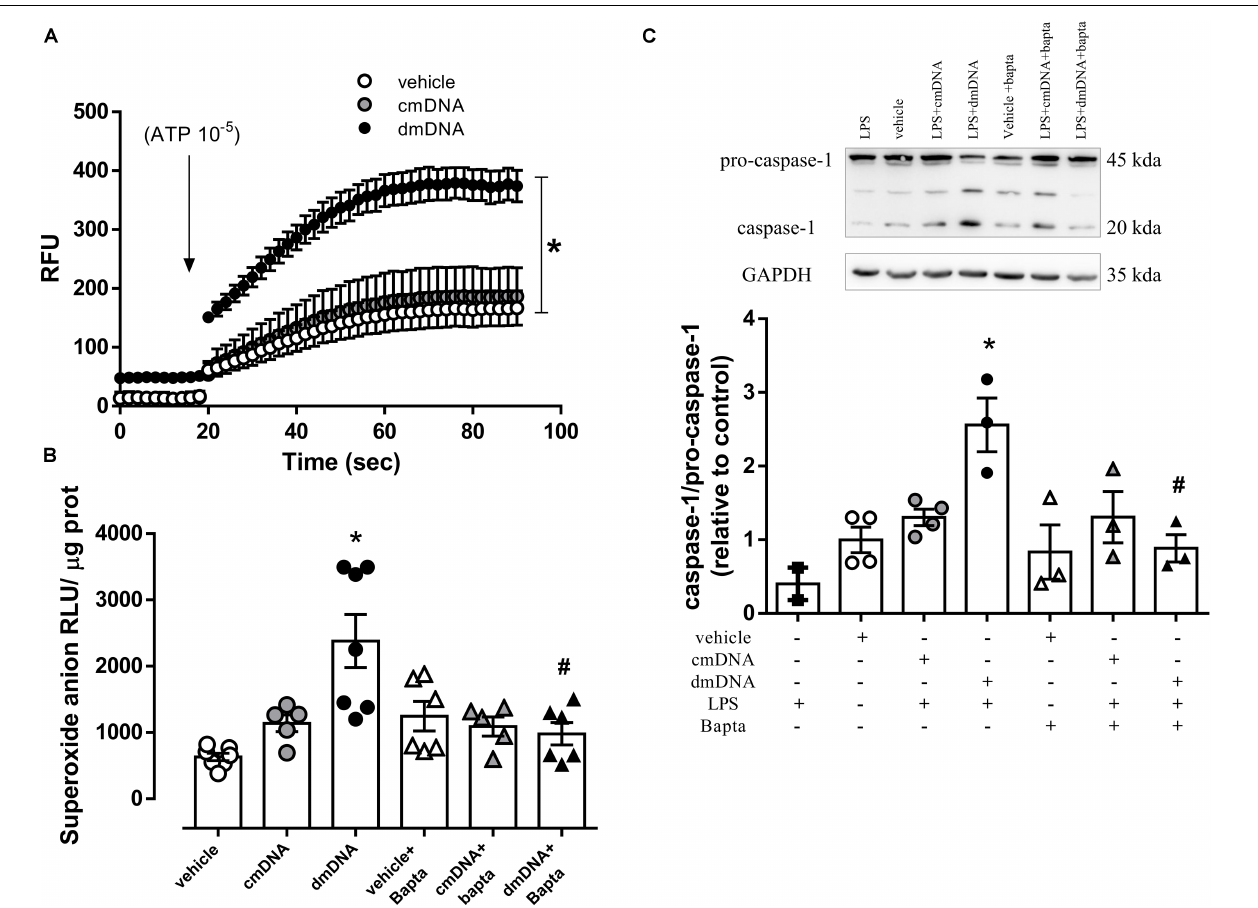
FIGURE 6 | (A) Ca 2 + influx and (B) superoxide anion generation in endothelial cells incubated with vehicle (white circles), mitochondrial DNA from control (cmDNA, gray circles) or diabetic (dmDNA, black circles) mice in the presence of vehicle (white triangles) or a Ca 2 + chelator (Bapta, gray and black triangles). On top, representative images of western blot and, at the bottom, densitometric analysis of the expression of (C) caspase-1 and pro-caspase-1 in endothelial cells primed with lipopolysaccharide (LPS) and incubated with vehicle (white squares), mitochondrial DNA from control (cmDNA, gray circles) or diabetic (dmDNA, black circles) mice in the presence of vehicle (white triangles) or a Ca 2 + chelator (Bapta, gray and black triangles). Each point/column represents the mean ± SEM. ∗ P < 0.05 vs. vehicle, # P < 0.05 vs. dmDNA. N = 5–12, one-way ANOVA (A–C) .